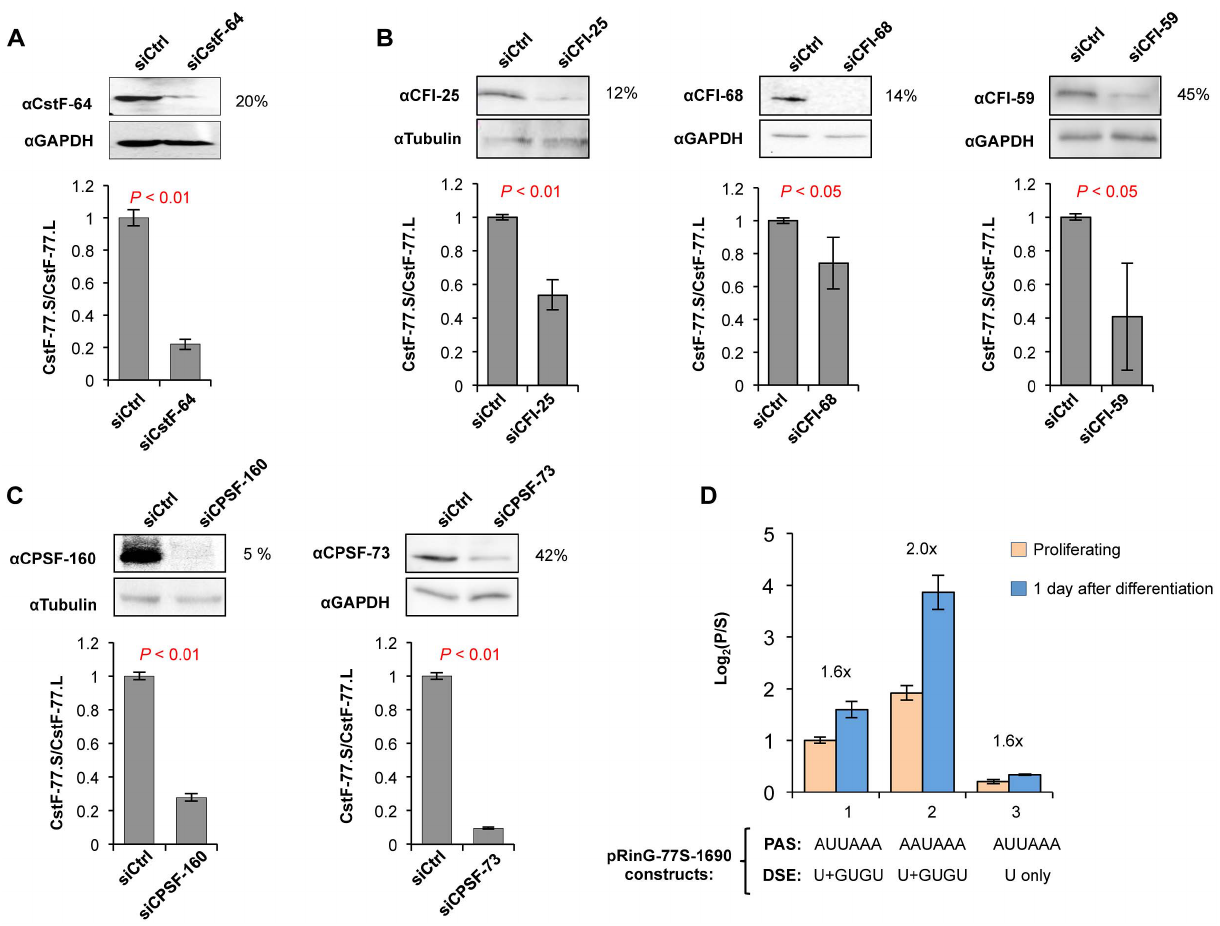
Figure 5. The intronic pA of CstF-77 gene is regulated by other C/P factors. ( A ) Effect of CstF-64 knockdown by siRNA on the CstF-77.S/CstF- 77.L ratio. Top, Immunoblot (IB) showing knockdown efficiency; bottom, CstF-77.S/CstF-77.L ratio as measured by RT-qPCR. P-value (T-test) comparing knockdown and control siRNA samples is shown. ( B ) As in (A), except that knockdowns of CFI-25 (left), CFI-68 (middle), and CFI-59 (right) are shown. ( C ) As in (A), expect that knockdowns of CPSF-160 (left) and CPSF-73 (right) are shown. ( D ) Expression of isoforms P and S from various pRinG-77S-1690 reporter constructs in proliferating and differentiating (1 day of differentiation) cells. The PAS type and DSE type of each construct are indicated (see Figure 2C for detail). The ratio of the log 2 (P/S) value from proliferating cells to that from differentiating cells is indicated, where P represents the abundance of isoform P and S the abundance of isoform S. The difference in log 2 (P/S) value (proliferating cells vs. differentiating cells) is statistically significant ( P , 0.05, T-test) for all three constructs.